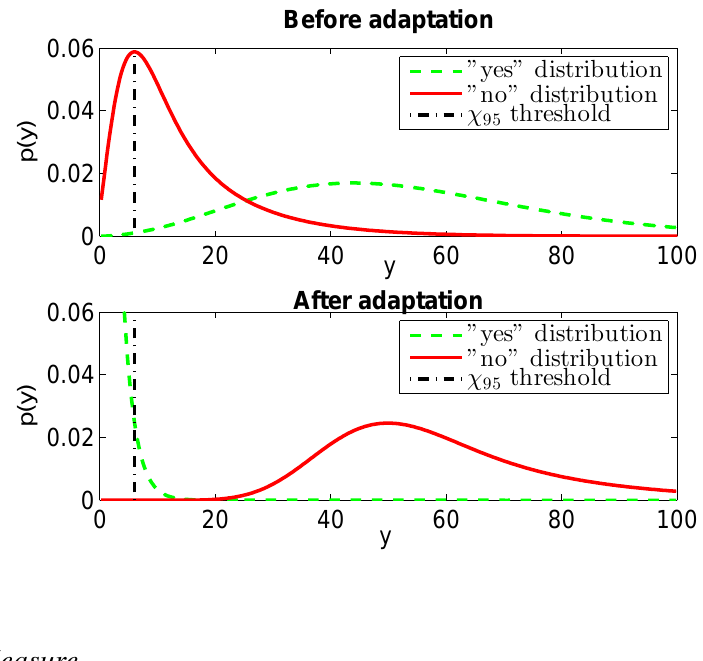
Figure 4. Simulated likelihood distributions before and after perfect